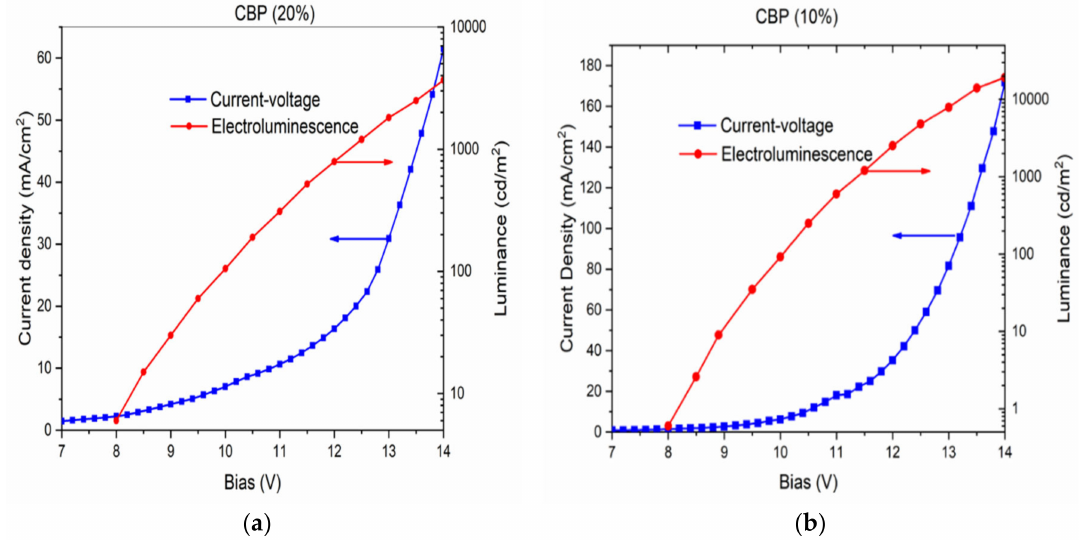
Figure 7. ( a ) The current density and luminance curves as a function of applied voltage for IrQ(ppy) 2 (20%) in CBP. ( b ) The current density and luminance curve as a function of applied voltage for IrQ(ppy) 2 (10%) in